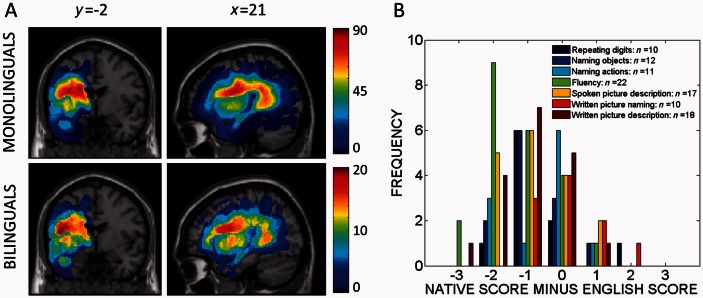
Patient data. (A) Frequency maps of the two patient groups’ lesions. Two lesion frequency maps in standard (MNI) space, with sagittal and coronal slices centred at x = −21 mm, y = −2 mm, z = 21 mm: the map for the monolingual group is on the top and the map for the bilingual group is at the bottom. (B) Histogram of the differences between the bilingual patients’ language scores in their (non-English) native language and in English. L1 scores were available in 7 of the 22 language assessments considered in the original analyses. The legend indicates both the names of the tasks and the numbers of scores available for comparison in each task. To support comparison across the language tasks, all differences (native language score minus English language score) were standardized to the same range: negative differences indicate that the patient’s language score was better when tested in English than when tested in their own (non-English) native language.